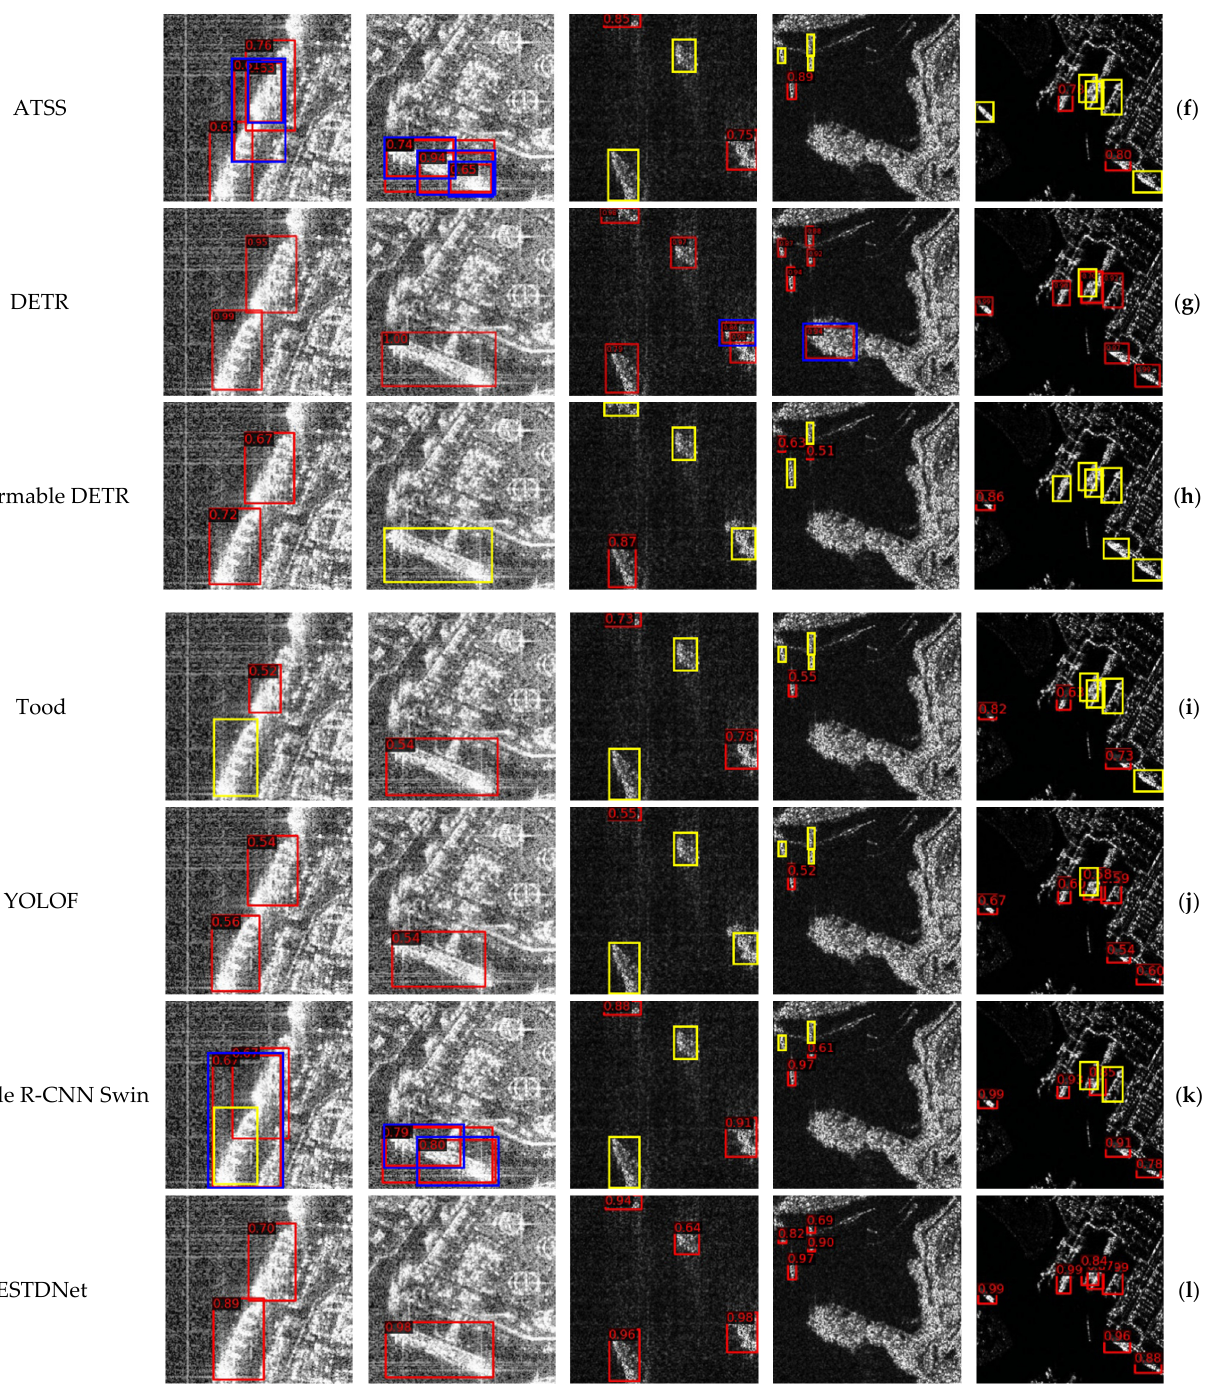
Figure 8. Experimental results in the SARShip dataset. ( a ): ground truth images; from ( b – l ): predicted results of Faster RCNN, YOLOv3, Cascade R-CNN, PAA, ATSS, DETR, Deformable DETR, Tood, YOLOF, Cascade R-CNN Swin, and ESTDNet, respectively. The ground truths, detection results, missed detection results and the false detection results are indicated with green, red, yellow, and blue boxes, respectively.